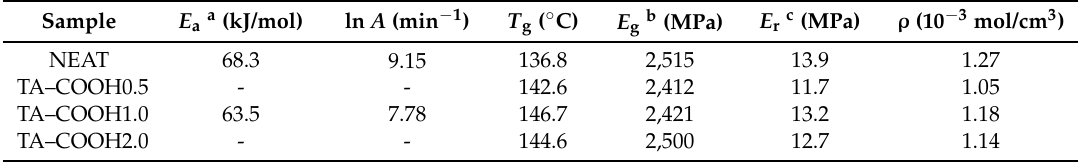
Figure 3. ( a ) DSC thermograms of neat epoxy and the TA–COOH modified epoxy resins and ( b ) degree of conversion against temperature of the curing of neat epoxy and the TA–COOH modified epoxy resins. Table 1. DMA and DSC results of the neat epoxy and TA–COOH modified epoxy resins.